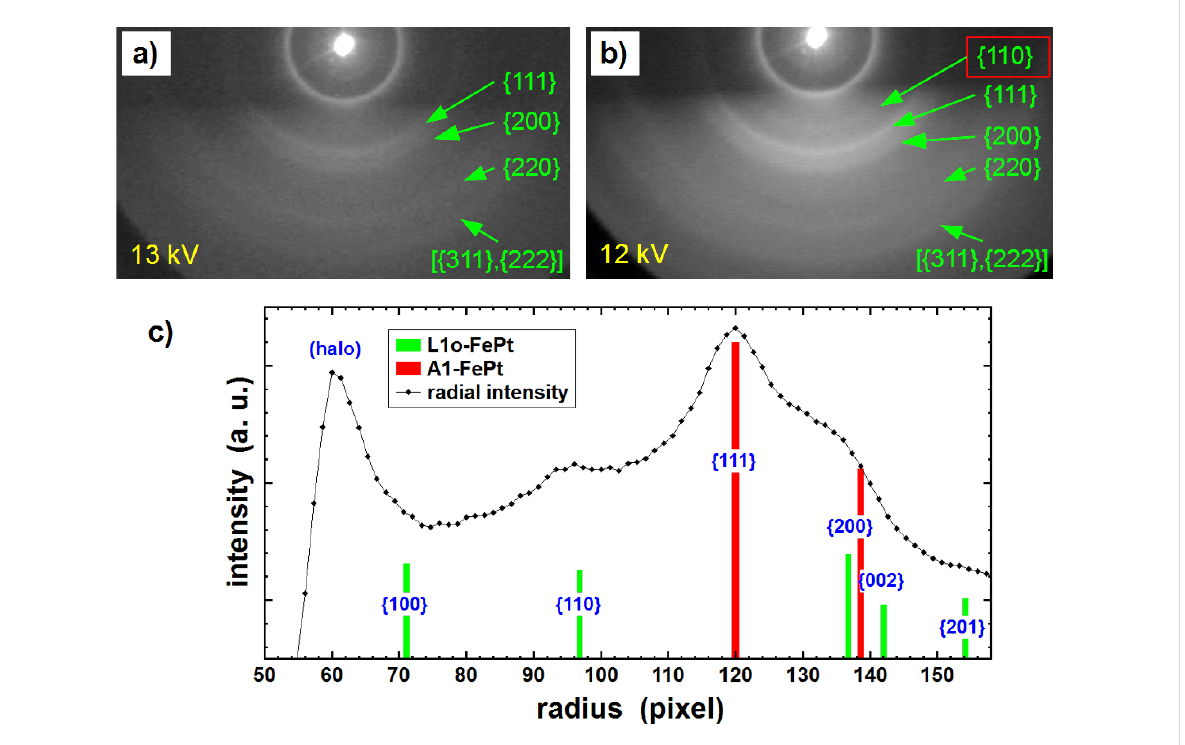
Figure 4: RHEED patterns of 7.6 nm FePt NPs on SiO 2 /Si(001) after different annealing steps (a) 570 °C for 60 min and (b) 630 °C for 45 min. Note the lower electron beam energies of 13 keV and 12 keV, chosen to avoid an overlap of the halo with the {110} ring. The homogeneous Debye–Scherrer rings are used for structural analysis and evaluation of the expected transformation towards the L1 0 phase. Panel (c) displays the integral of the radial intensity distribution after annealing at 630 °C. The red and green lines indicate the expected positions and intensities of the Debye–Scherrer